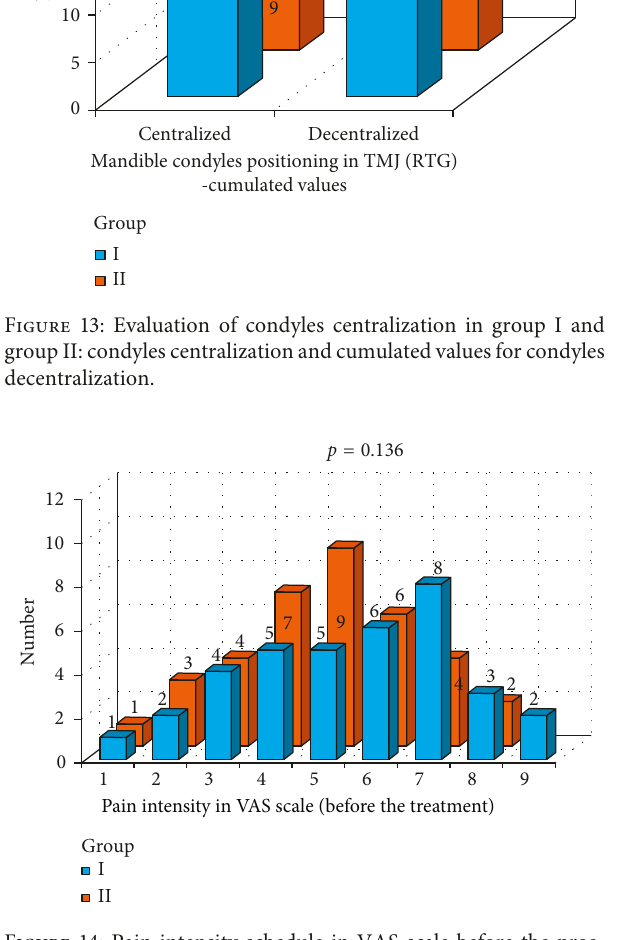
Figure 14: Pain intensity schedule in VAS scale before the pros- thodontic treatment: group I and group II